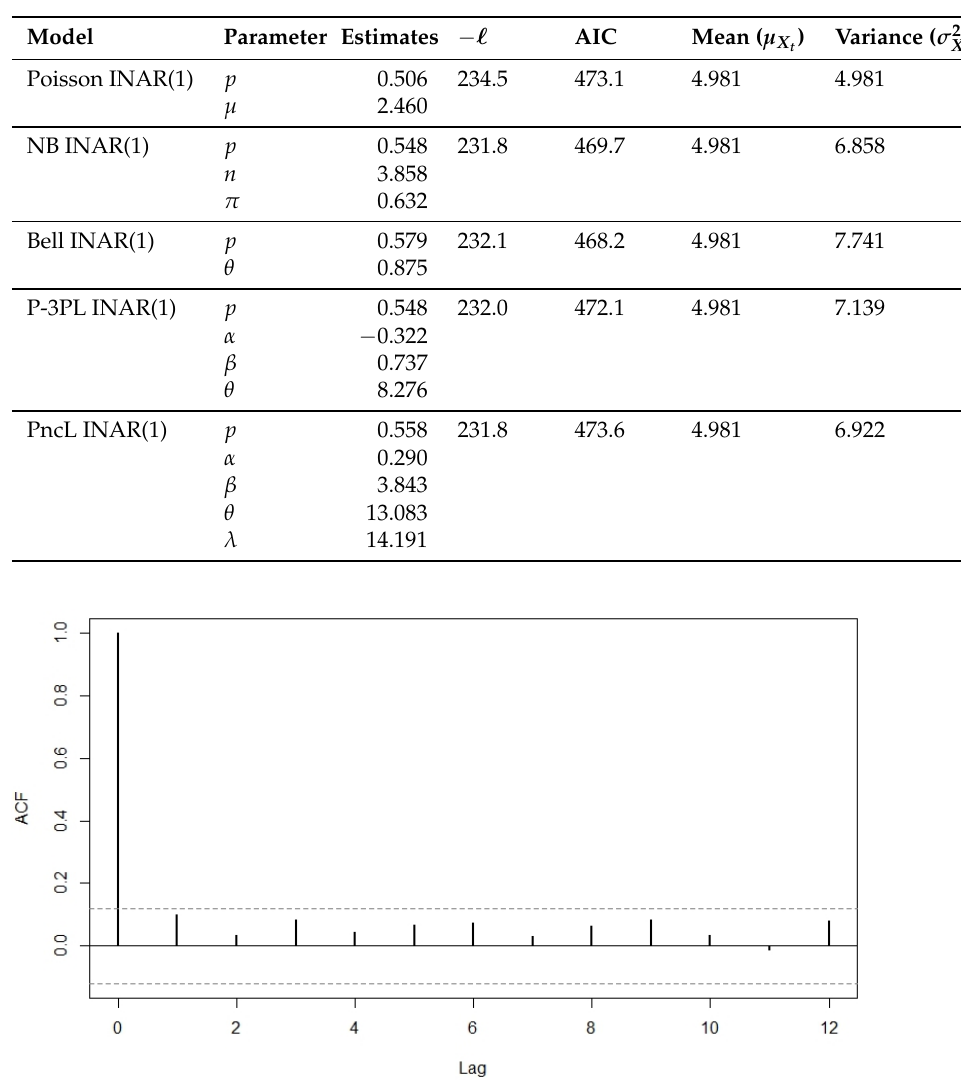
Table 9. Estimated parameters, goodness of fit statistics, fitted mean, and fitted variance of considered models for the strikes counts time series dataset.